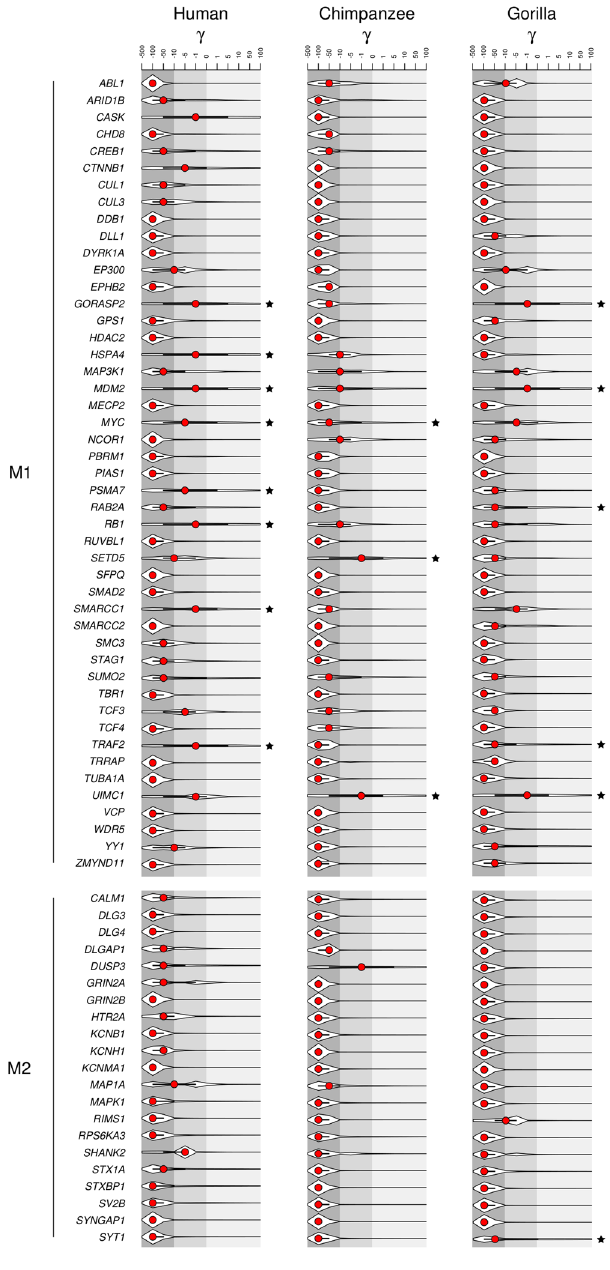
Figure 4. Population genetics-phylogenetics analysis in human, chimpanzee and gorilla lineages. Violin plot of selection coefficients for the the human, chimpanzee and gorilla lineages (median, red dot; interquartile range, black bar) for M1 and M2 genes. The gray shading denotes different degree of constraint based on selection coefficients. Black stars indicate genes with lineage-specific positively selected